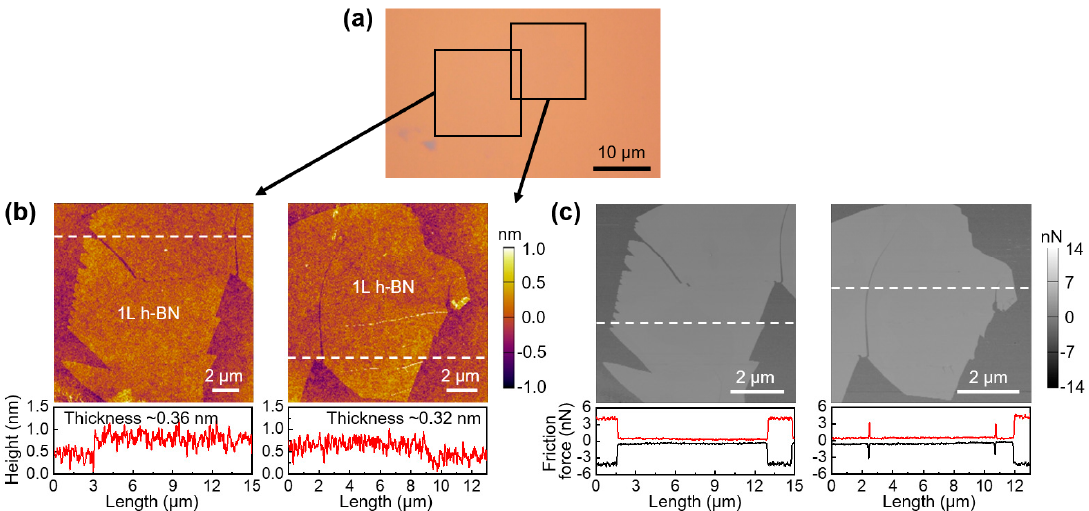
Figure 1. ( a ) Confocal microscopy image, ( b ) AFM topography images, and ( c ) FFM images of the 1L hexagonal-boron nitride (h-BN) on a SiO 2 /Si substrate deposited by mechanical